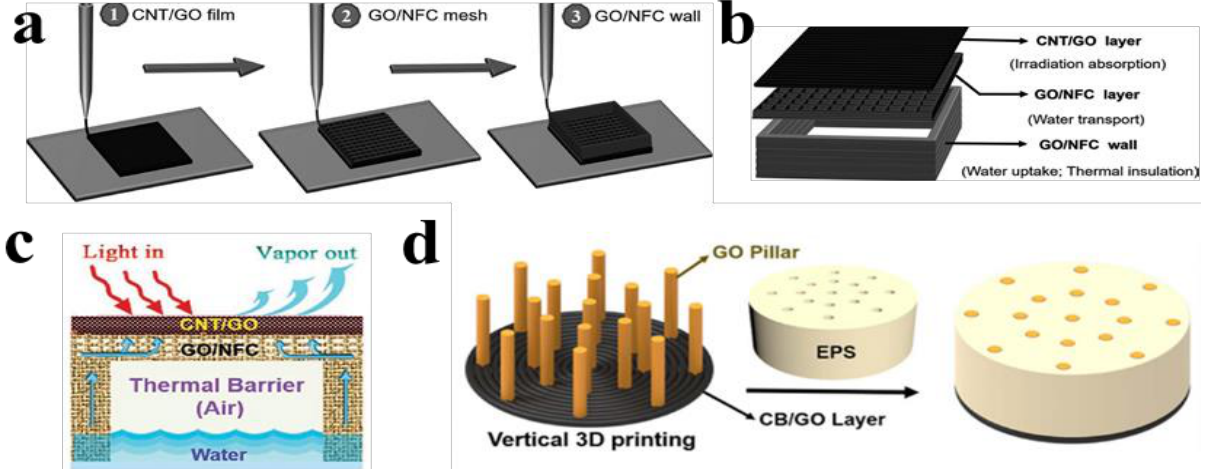
Figure 6: 3D printing for thermal management: (a) schematic showing the process of 3D printing fabrication and (b, c) structure of the